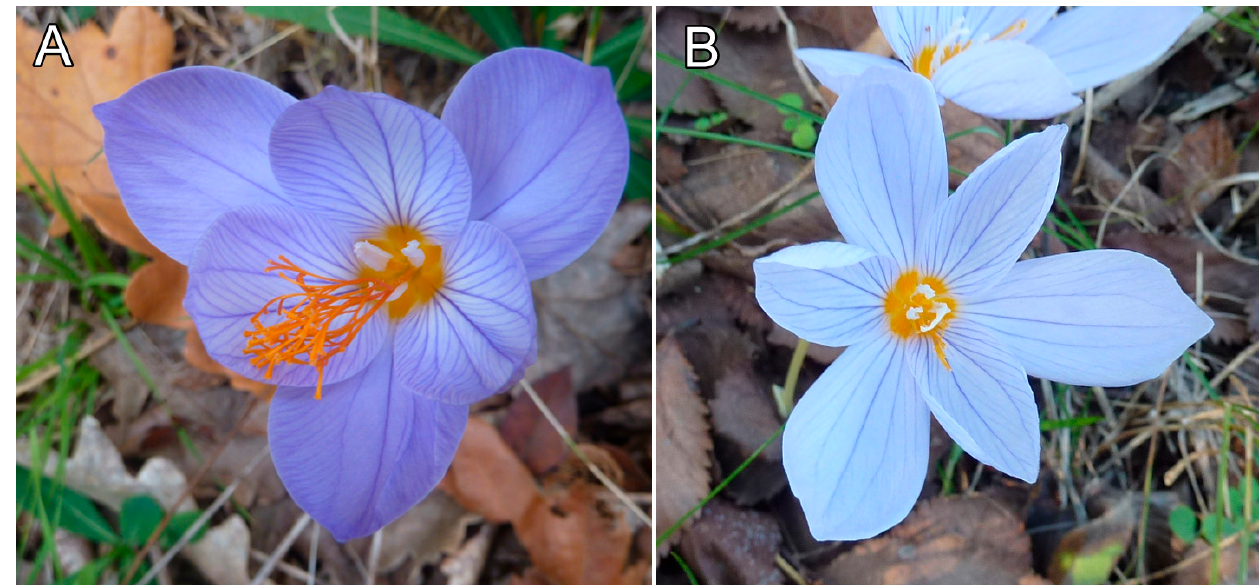
Figure 2. Flower: ( A ) Crocus speciosus ; ( B ) C. pulchellus.